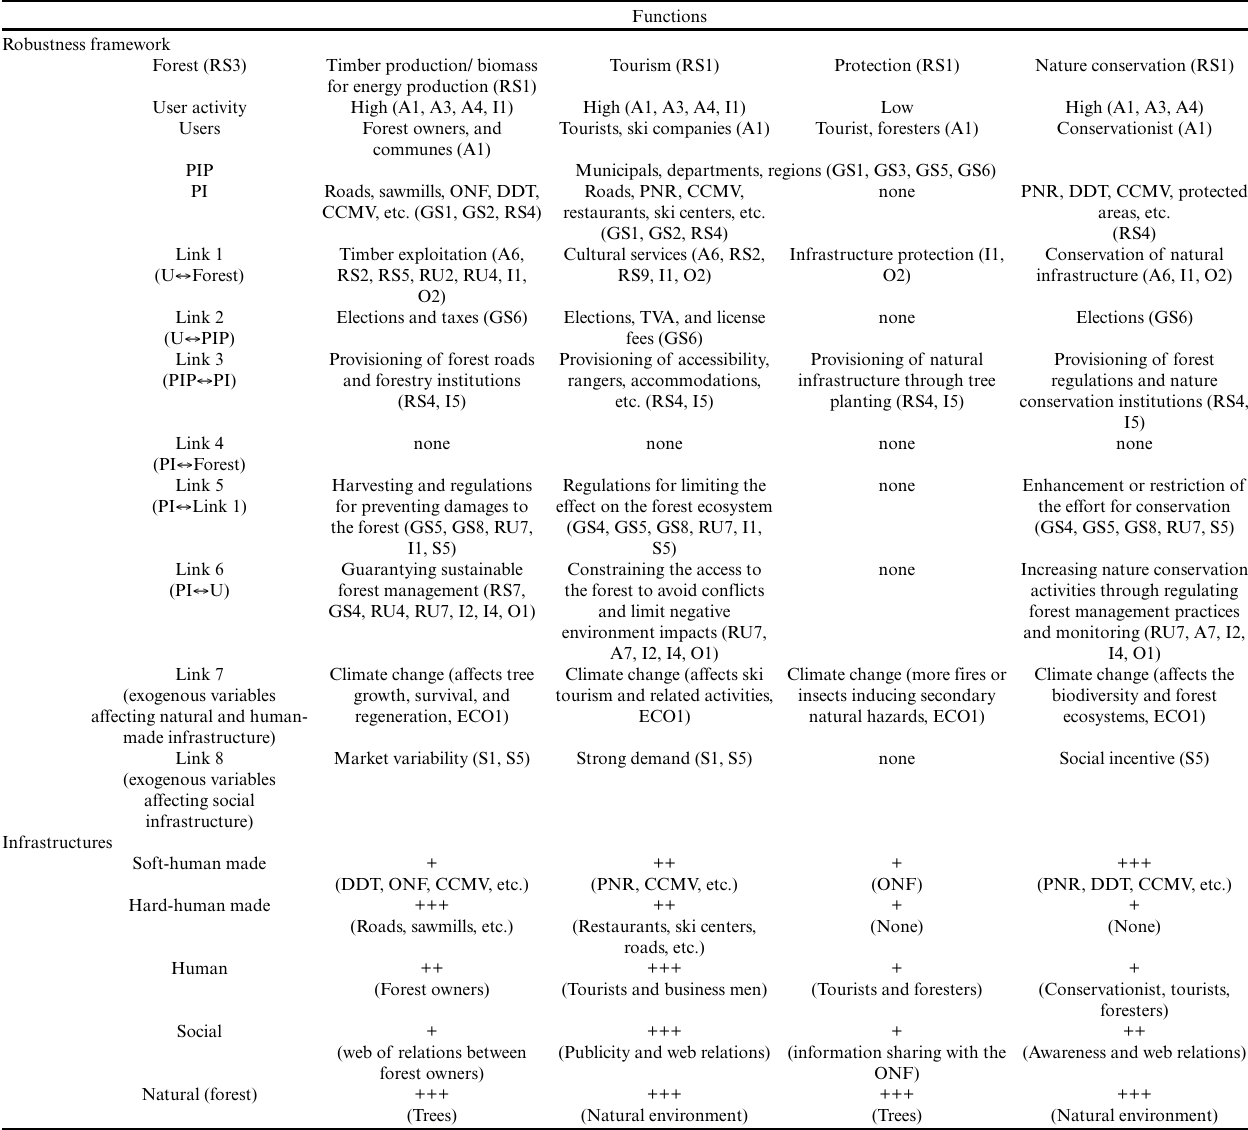
Table 1 . Forest functions from the point of view of the robustness framework and infrastructures. The table also shows the placement of the relevant social-ecological systems (SES) variables associated with components of the framework. The “+” measurements signify the importance of the types of infrastructure to the functionality of their relevant infrastructure (see Appendix 1 for more information on the measurements). See Figure 3 for explanation of codes (e.g., A1, GS1, RS1, etc.). Note: PIP = Public Infrastructure Providers; PI = Public Infrastructure; PNR = Parc Naturel Régional; DDT= Direction Départementale des Territoires; ONF = Office Nationale des Forêts; CCMV = Communauté de Communes du Massif du Vercors; RU = Resource users; TVA = Taxe sur la valeur ajoutée (tax on the added